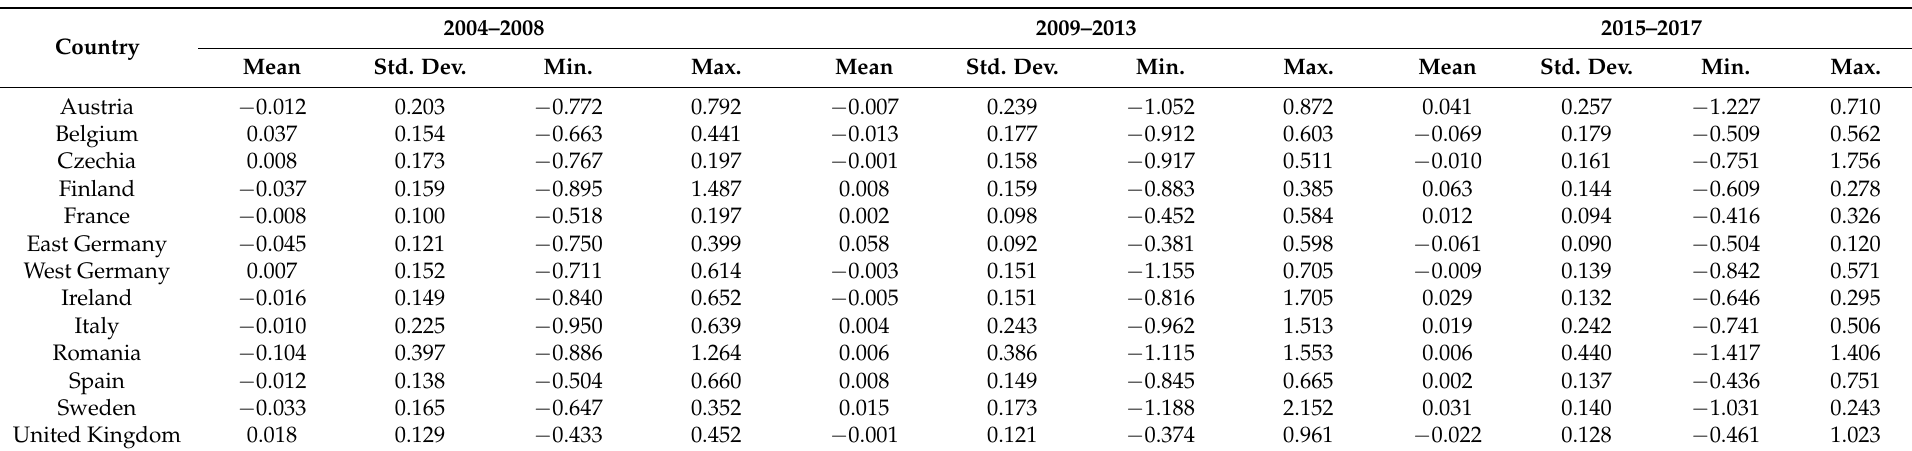
Table 5. Total factor productivity development (TTI). Source: own